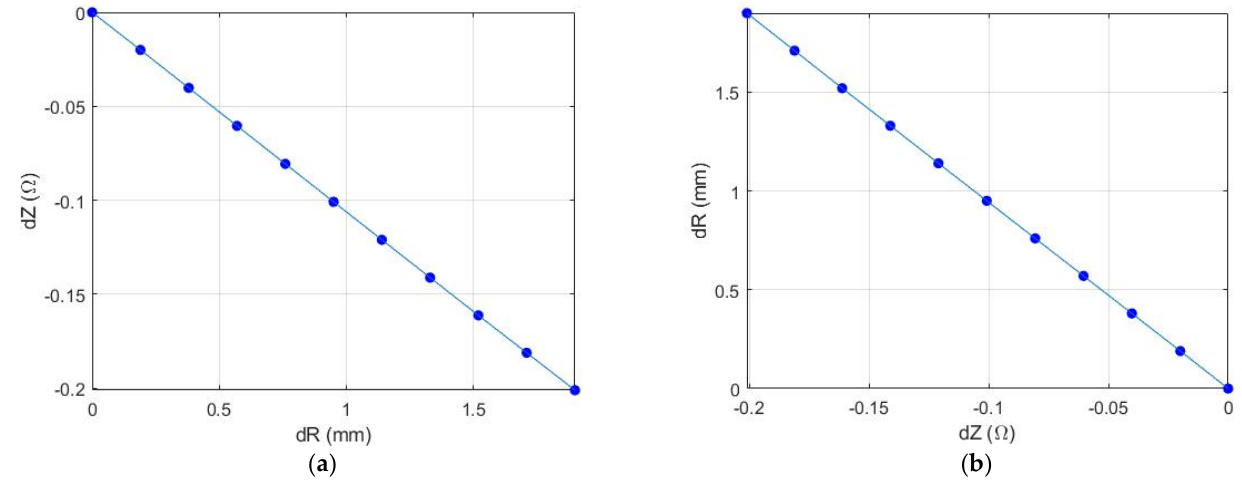
Figure 4. The dependence of electrical impedance changes due to artery diameter change: ( a ) The forward problem; ( b ) the inverse problem.